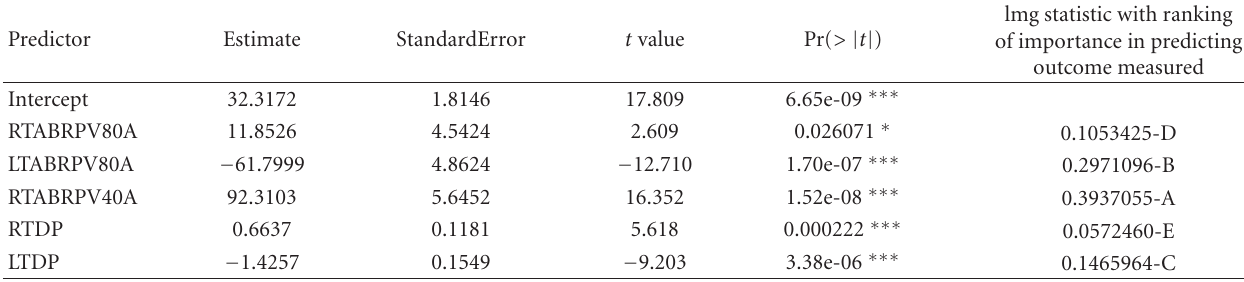
Table 2: Best-Subsets Linear Regression Coe ffi cients of five optimal predictors (selected from 24 original predictors) of carbon monoxide level based on N = 16 cases.